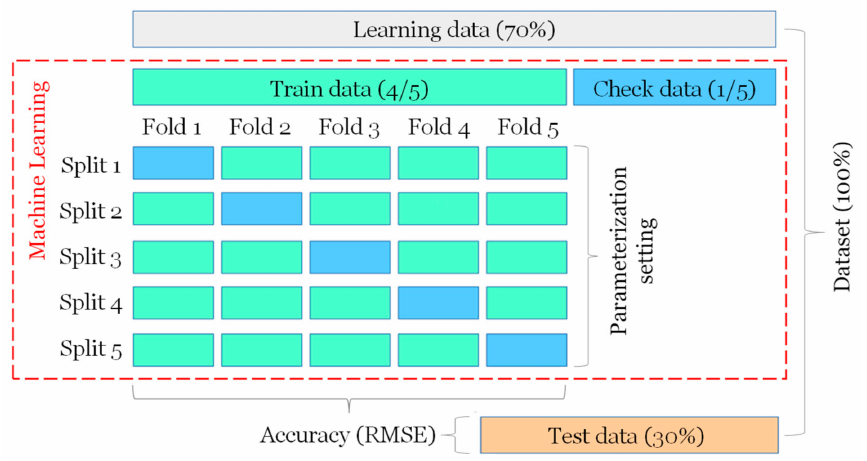
Figure 5. Determining parameterization settings based on 5-fold cross-validation. Source: modified from Scikit-learn developers [44].